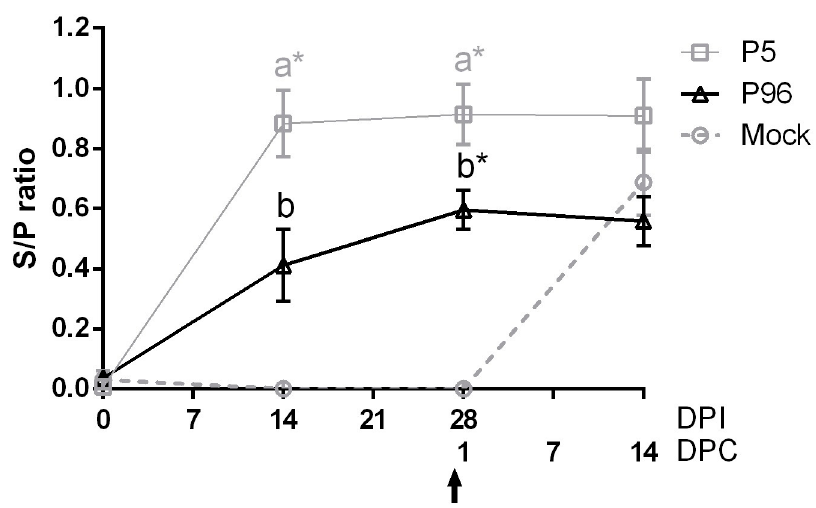
Figure 4. Changes in PEDV-specific immunoglobulin G (IgG) levels in plasma after PEDV strain Pintung 52 (PEDVPT)-P5 or PEDVPT-P96 inoculation and after PEDVPT-P5 challenge in all pigs. Plasma samples from ethylenediaminetetraacetic acid (EDTA)-anticoagulated blood were collected biweekly and diluted 20-fold. The levels of PEDV-specific IgG were detected by ELISA with PEDV particles as coating antigen and expressed as sample-to-positive control ratios (S/P ratio). S/P ratios were defined as the difference between the optical density ( OD ) values of sample and negative control divided by the difference between OD values of positive and negative controls. PEDV-specific plasma IgG levels are represented as mean ± SEM. The arrow indicates the time point when pigs were challenged with the low passage PEDVPT-P5 (27 DPI or 0 DPC) strain. The black, gray, and dashed lines illustrate the results for the PEDVPT-P96-inoculated group, PEDVPT-P5-inoculated group, and mock-infected group, respectively. *: significant difference with the mock group ( p < 0.05); a, b: significant difference between groups labeled with different alphabets ( p < 0.05).